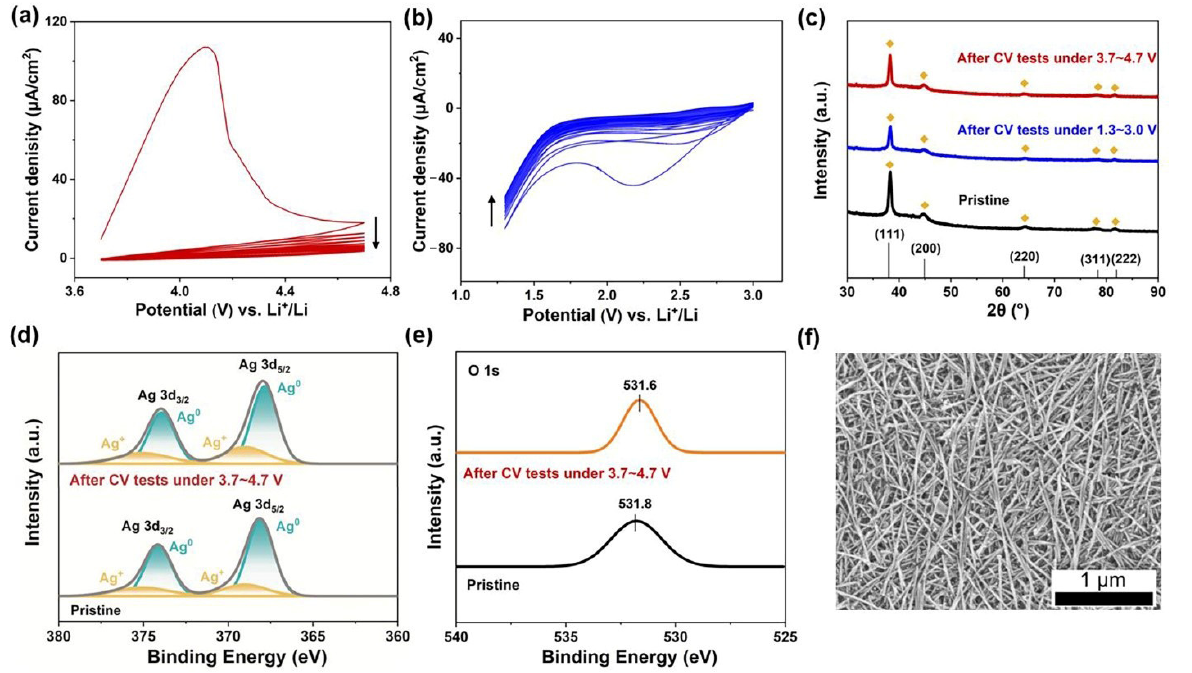
Figure 2. Cyclic stability of AgNW film (areal density of 200 μ g/cm 2 ) in the molecular crowding electrolyte. ( a , b ), Cyclic voltammetry curves of the AgNW film within 3.7–4.7 V vs. Li + /Li and 1.3–3.0 V vs. Li + /Li at a scan rate of 0.5 mV/s. ( c ) XRD patterns of the AgNW film before and after cyclic voltammetry tests. The standard card of Ag (JCPDS PDF#25-1325) is also presented. ( d ) XPS patterns of Ag 3d of the AgNW film before and after cyclic voltammetry tests. ( e ) XPS patterns of O 1s of the AgNW film before and after cyclic voltammetry tests. ( f ) Typical SEM image of the AgNW film after 20 cycles of cyclic voltammetry tests within 3.7–4.7 V vs. Li +